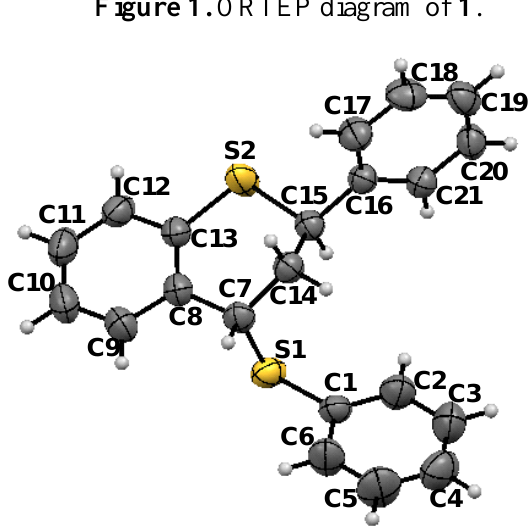
Figure 1. ORTEP diagram of 1